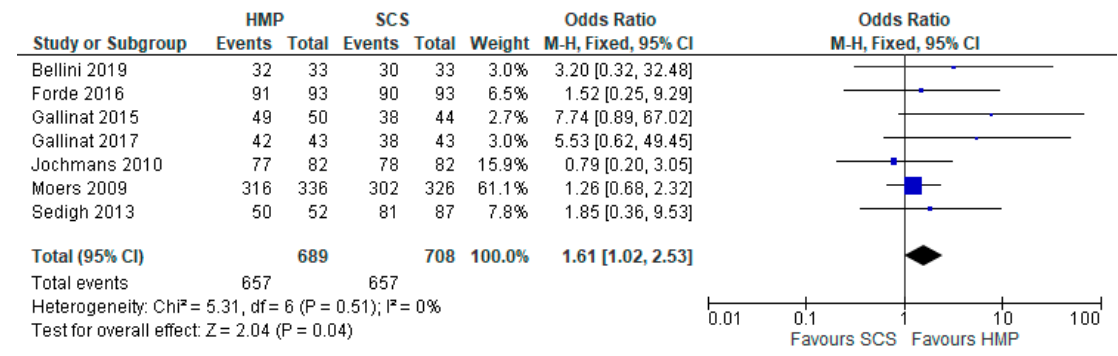
Figure 7. One year graft survival in kidneys preserved via HMP and SCS.